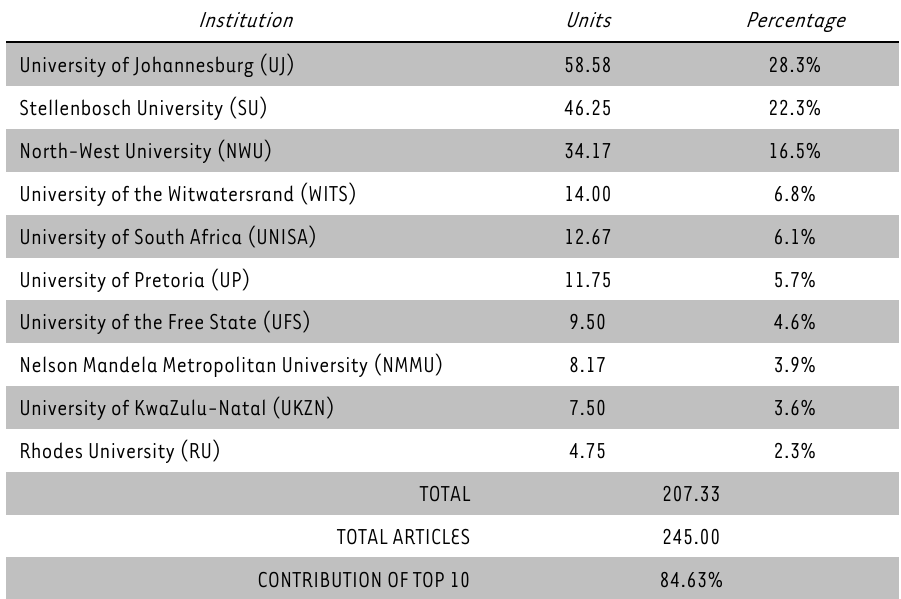
TABLE 4: The top 10 contributing institutions to the